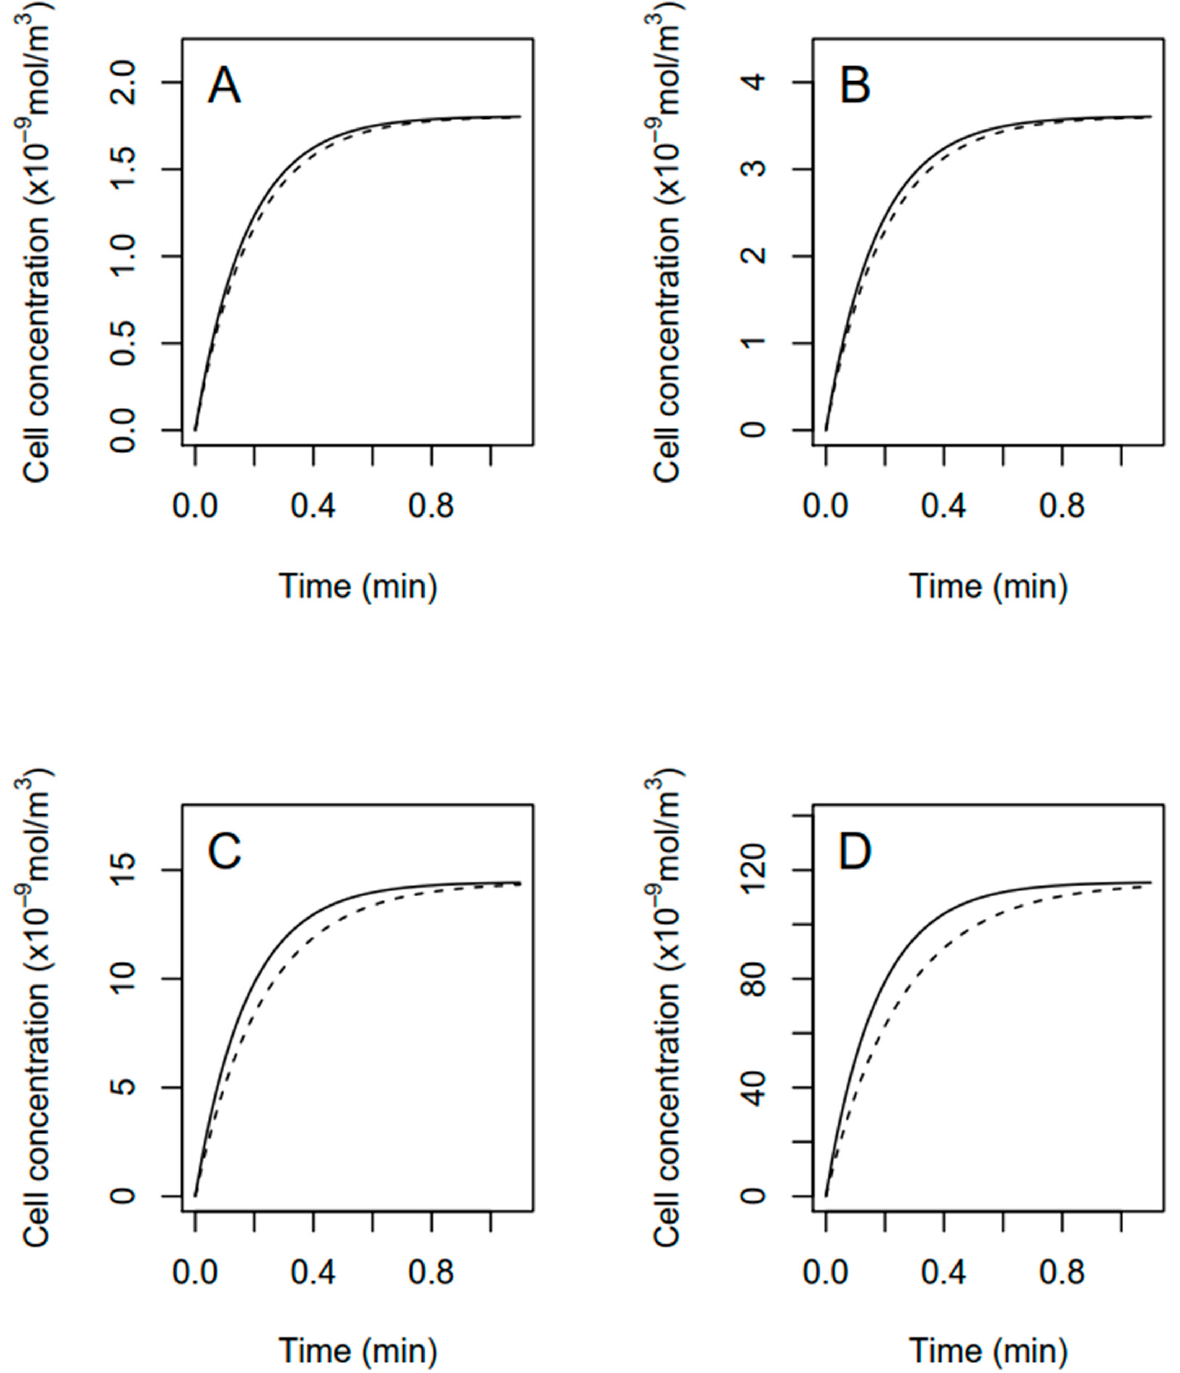
Figure 8. Modeled cellular concentration of fomesafen in R. subcapitata exposed to 5, 10, 40 and 320 µ g · L − 1 (panel ( A – D )) total fomesafen until approaching steady-state. Computations assume that all fomesafen taken up is tightly bound in the cell, i.e., negligible active fomesafen efflux from the cell. Solid lines assumed a low constant cell biovolume equal to the mean measured initial cell biovolume. Dashed lines assume a high constant mean cell biovolume measured after 72 h of exposure.